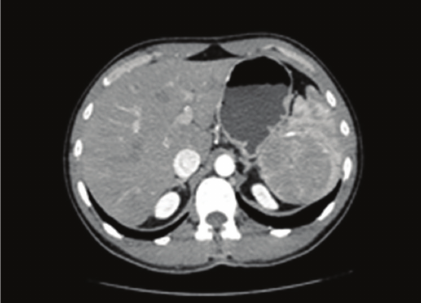
Figure 2: Disposition of trocars for laparoscopic splenectomy.